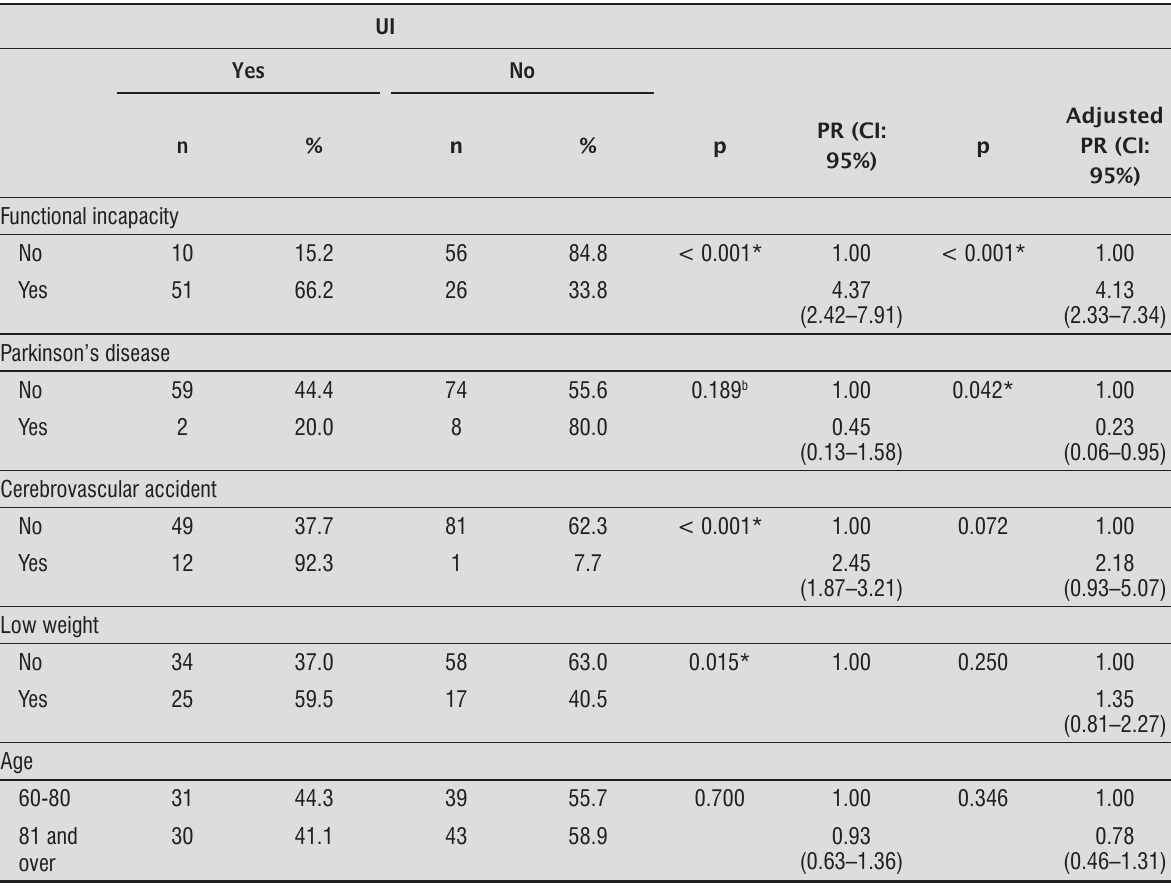
Table 4 - Results of multivariate analysis – Natal (RN),